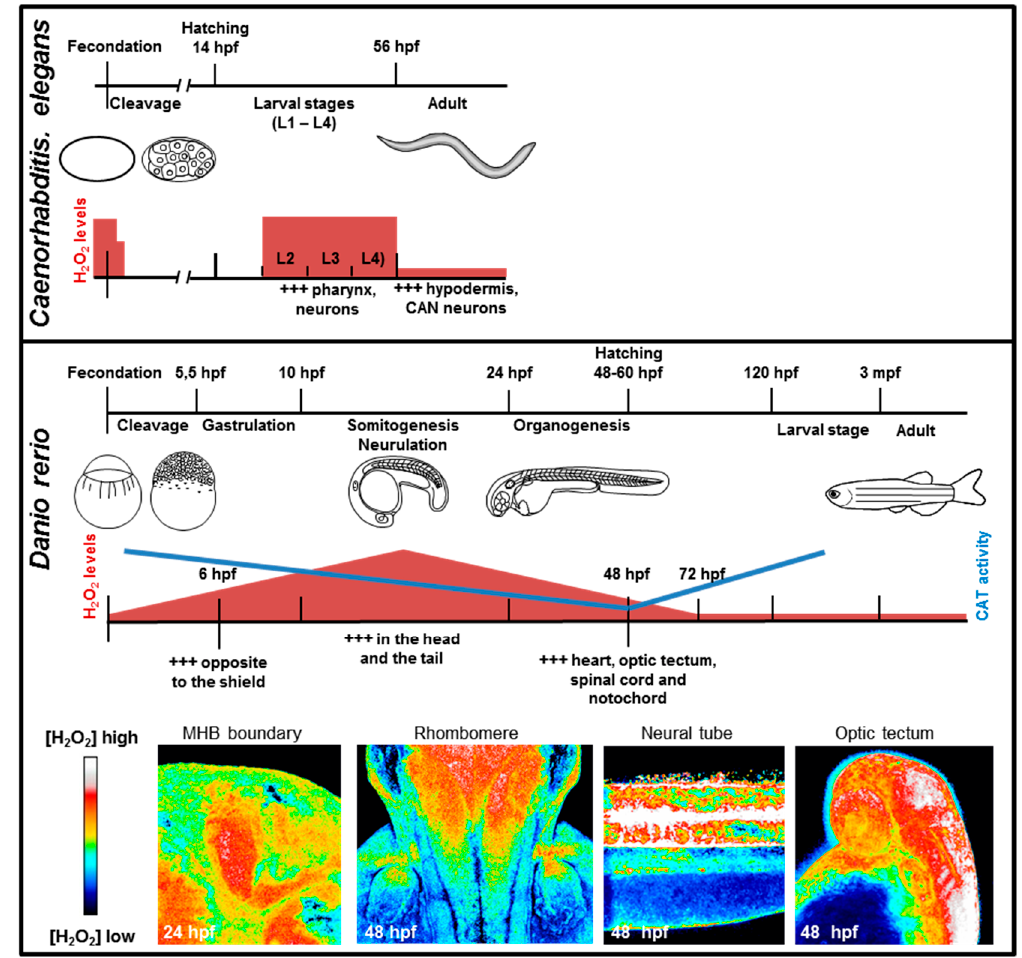
Figure 2. H 2 O 2 detection during development. Upper panel: H 2 O 2 detection during C. elegans development. Adapted from [62] and [60]. Middle panel: H 2 O 2 levels and catalase activity during Danio rerio development. Adapted from [61]. Lower panel: HyPer fish reveal spatio-temporal dynamic and gradients of H 2 O 2 during neural development. hpf: hours post fertilization, mpf: month post fertilization.